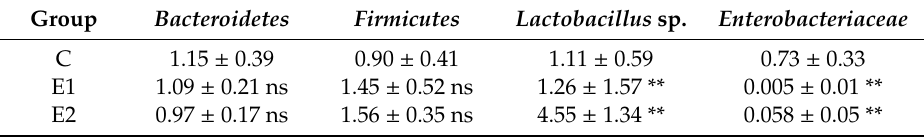
Table 5. The relative abundance of Firmicutes, Bacteroidetes, Lactobacillus sp, and Enterobacteriaceae phyla as determined by The Real-Time Quantitative Reverse Transcription PCR (qRT-PCR): Eubacteria 16S rRNA was used for